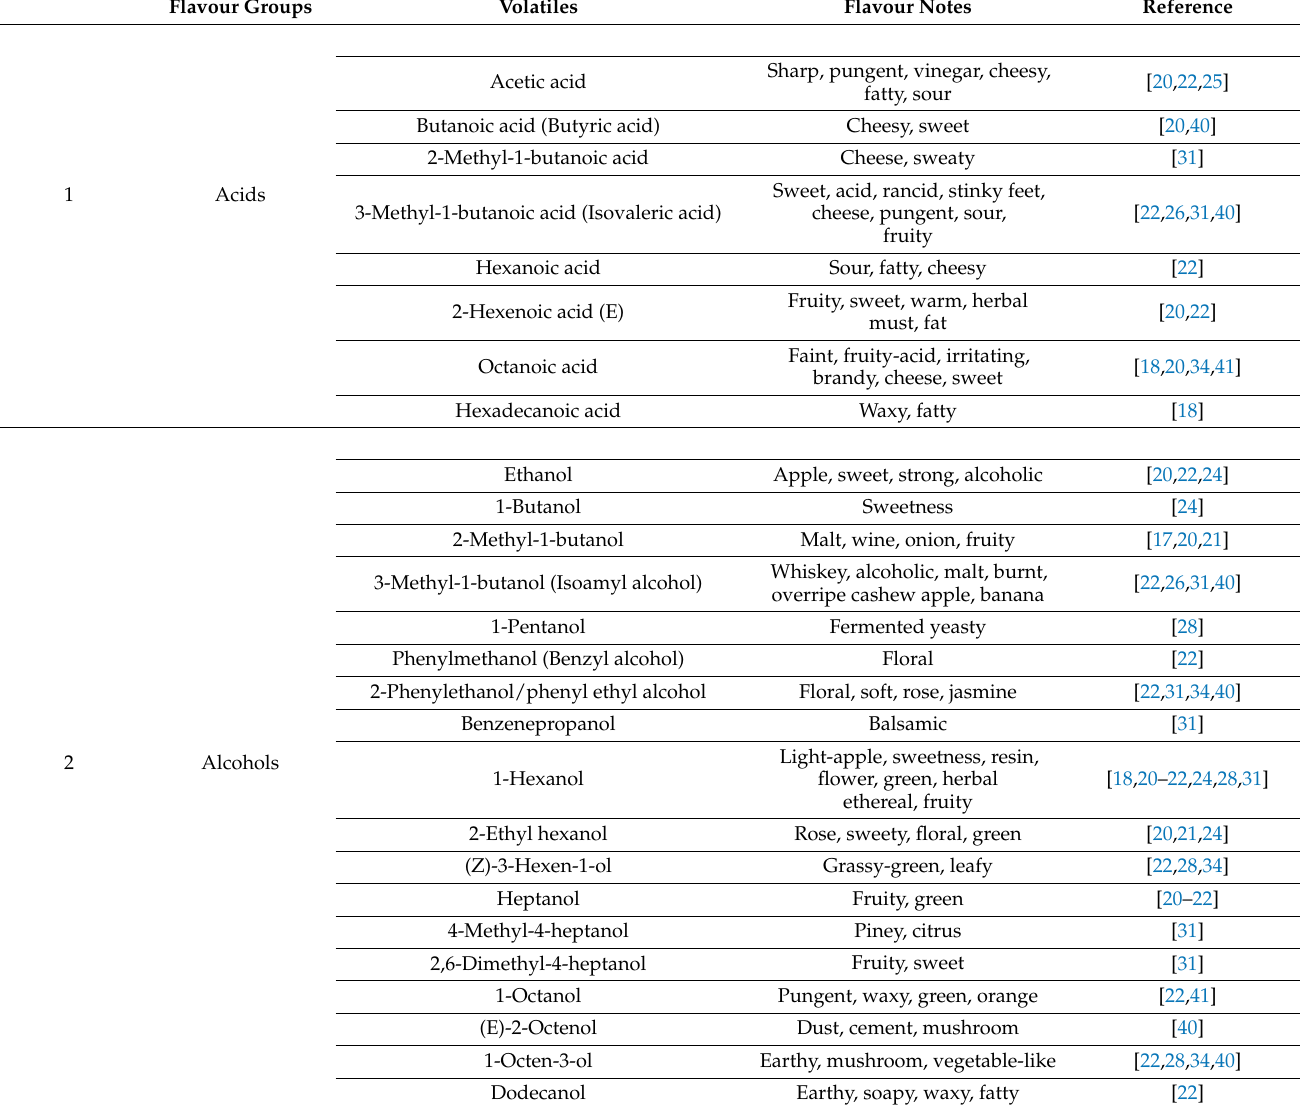
Table 3. Flavour notes of important